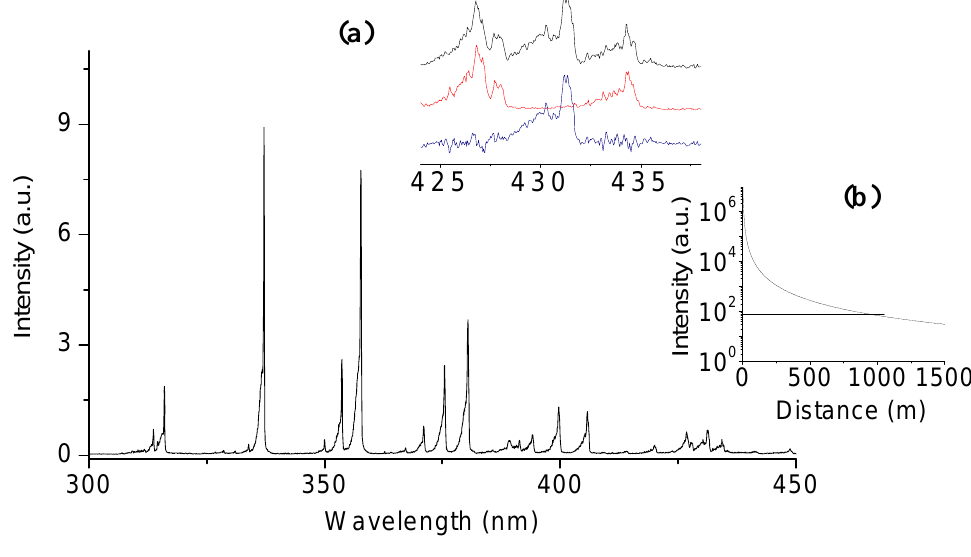
and air with a CH Figure 4. Filament-induced fluorescence spectrum of mixture of CH 4 4 concentration of 2.6% (v./v.). The inset (a) shows the spectrum in a higher resolution (top), the spectrum of pure air in atmospheric pressure (middle), and the subtraction of the mixture and pure air spectra (bottom). The band results from the A 2  -X 2 П transition of CH. The inset (b) shows the extrapolation of the detection limit according to the LIDAR equation ( I = L / R 2 , where I is the signal intensity, L the effective filament length and R the distance between the end of the filament and the detector). The 3 σ detection limit was about 0.9 km for the CH concentration of 5% and the filament length of 20 m, where σ is 4 the standard deviation of the background